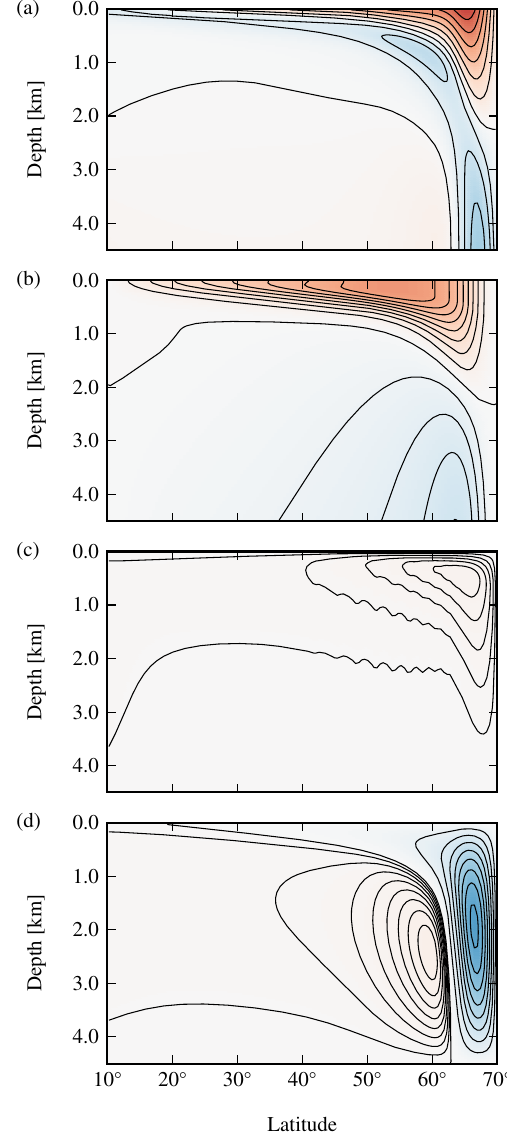
Fig. 3. Velocity fields of the standard solution: (a) interior zonal velocity u i (contour interval 0.5cms − 1 ), (b) western-boundary meridional velocity v w (contour interval 1cms − 1 ), (c) western- boundary vertical velocity w w (contour interval 0 . 2 × 10 − 5 ms − 1 ), and (d) eastern-boundary vertical velocity w e (contour interval 0 . 2 × 10 − 5 ms − 1 for positive values, 2 . 0 × 10 − 5 ms − 1 for nega- tive values). Red shading indicates positive values; blue shading indicates negative